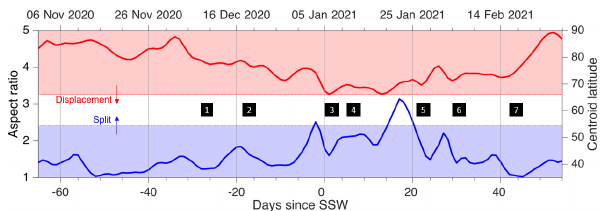
Figure 6. Red line shows the centroid latitude and blue line shows the aspect ratio of the polar vortex around the time of the Jan- uary 2021 SSW, computed from ERA5 GPH at the 10hPa level following the method of Seviour et al. (2013). Unshaded region in- dicates anomalous values indicative of a major vortex distortion, i.e. a split vortex for the blue line or a displaced vortex for the red line. Numbered boxes across the centre of the plot are used to guide discussion from Sect. 6